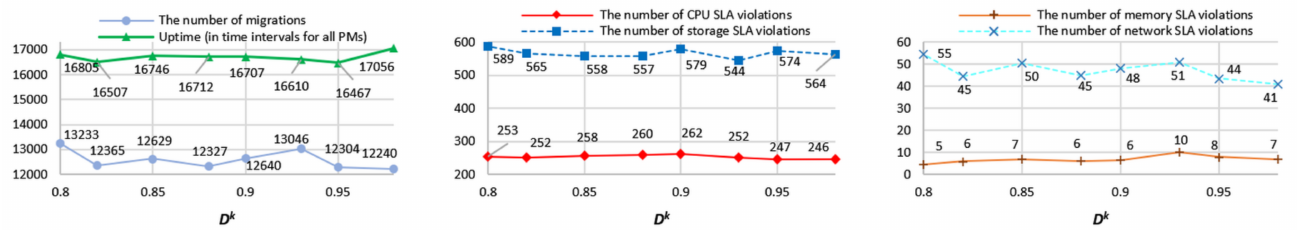
Figure 10. The effect of D k on the quality metrics for SLA violation